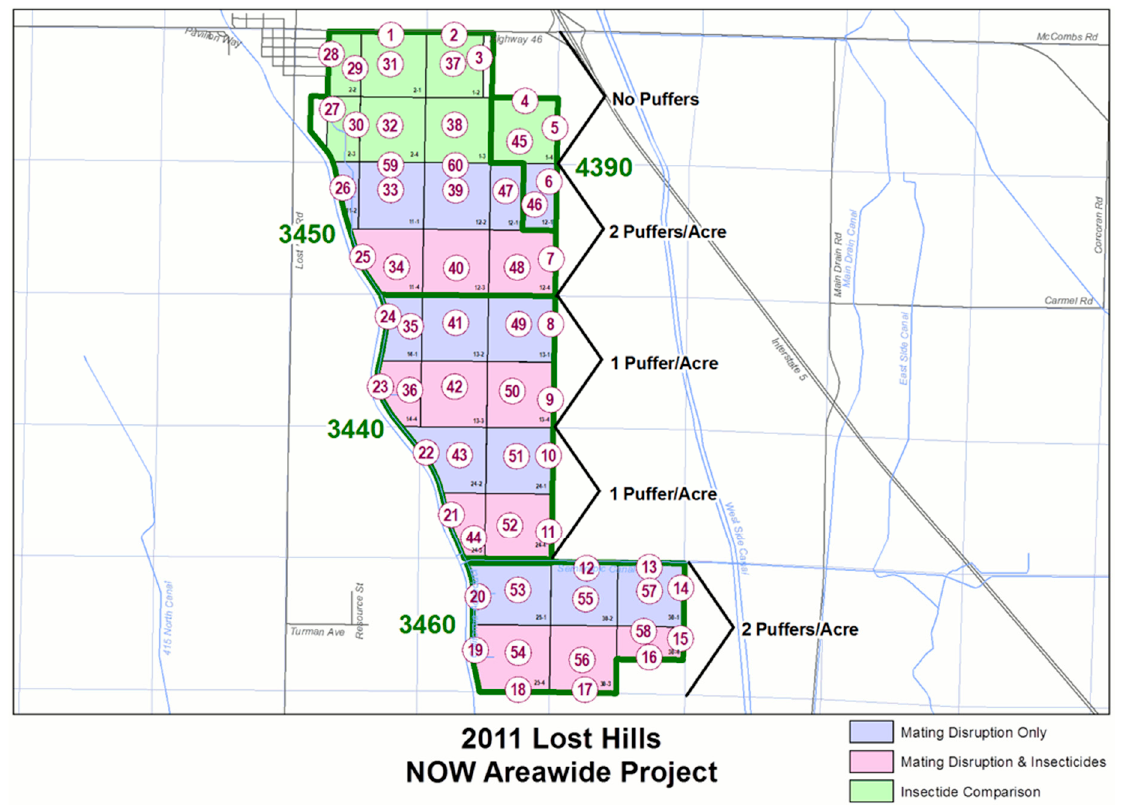
Figure 1. Representative map for treatment areas (blocks) in a commercial almond orchard in 2011. The two blocks with sites 4, 5, 6, 45, and 46 (upper right portion of map) are pistachio orchards and not included in this study.